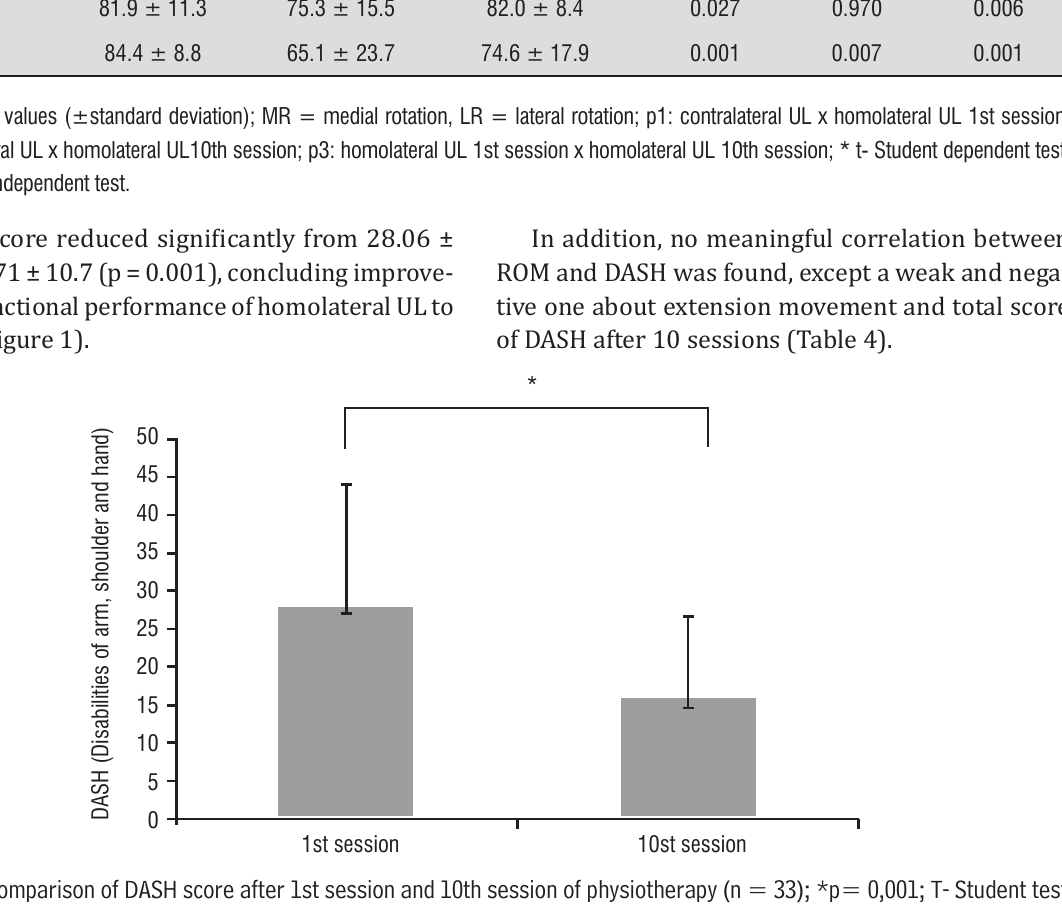
Table 3 - Comparison of range of motion (ROM) after 1st and 10th session of physiotherapy (n = 33) ROM